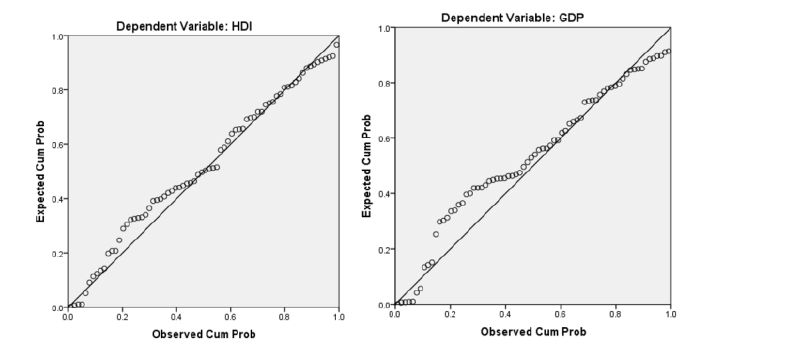
Figure 2: P-Plot; Source: Output SPSS